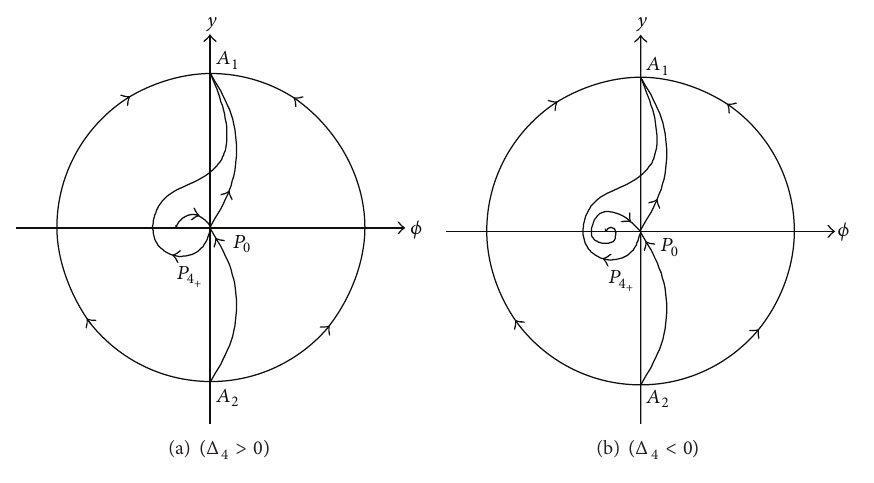
Figure 9: ( 𝛽 > 0 , 𝑎 < 0 , 𝑏 = 0 , 𝑐 > 0